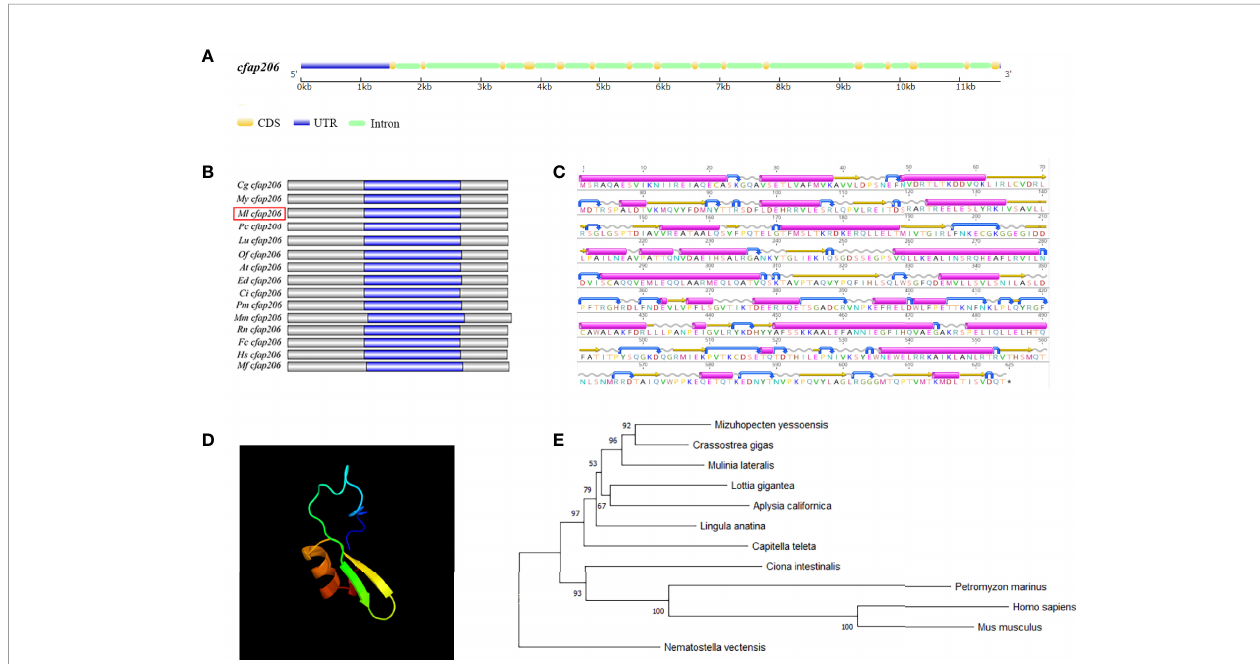
FIGURE 1 | Characterization of Cfap206 in M. lateralis andphylogenetic analysis. (A) Geneticstructure of Cfap206 . CDS, codingsequence; UTR, untranslated region. (B) Protein structures of CFAP206s of fi fteen representative species. Grey represents the whole protein region, and the magenta region represents the CFAP206 domain of each species. (C) Prediction of the secondary structure of CFAP206 protein. Magenta represents a -helixes, yellow represents b -folds, blue represents b -bends, and gray represents random coils. (D) Prediction of the tertiary ferritin-like structure within the CFAP206 domain (420aa-467aa). (E) Phylogenetic analysis of CFAP206